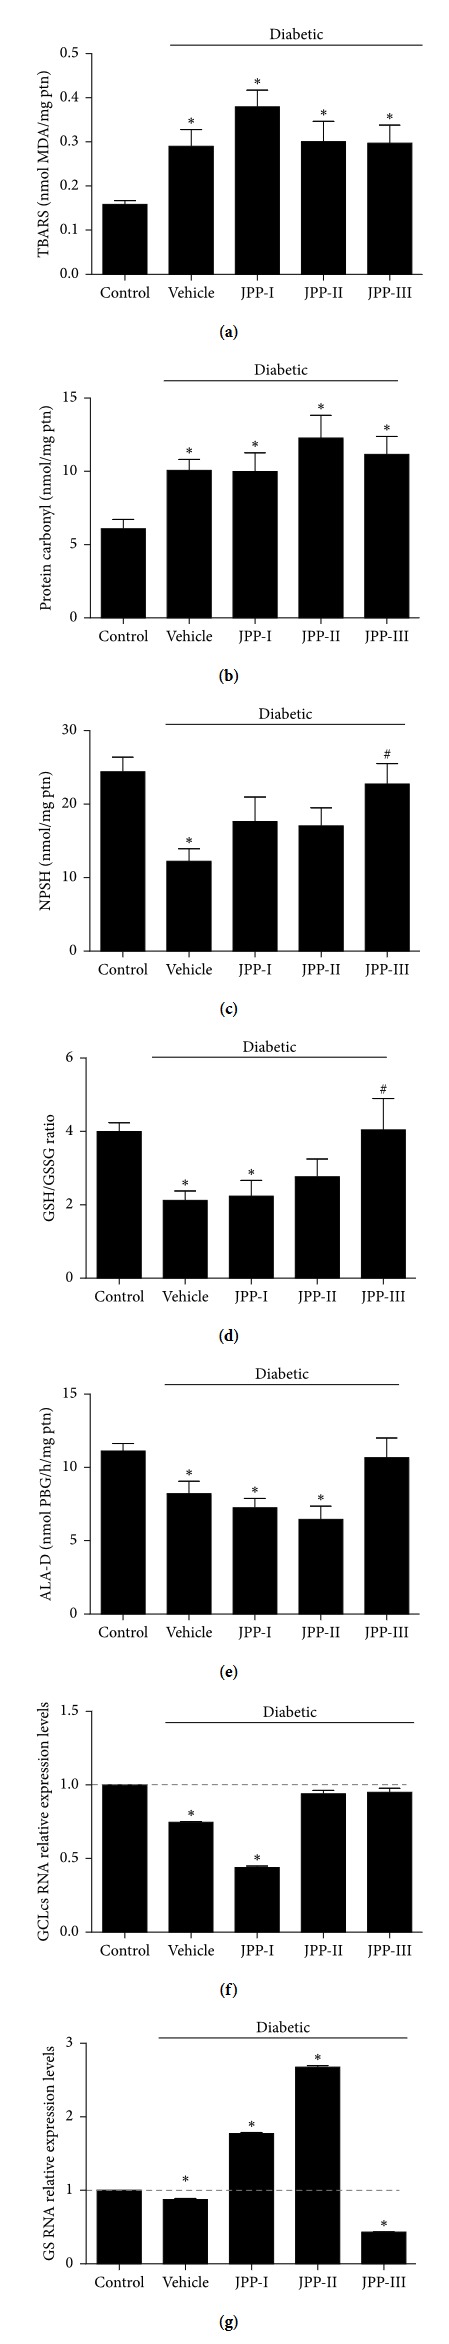
TBARS (a), protein carbonyl (b) and NPSH (c) levels, GSH/GSSG ratio (d), δ-ALA-D activity (e), and gene expression of GCLcs (f) and GS (g) in the liver of diabetic rats fed high-fat diet and treated with jaboticaba peel powder or vehicle for 8 weeks (means ± SEM, n=8). ∗Different from the control group (p < 0.05). #Different from the diabetic-vehicle group (TBARS, protein carbonyl, NPSH, GSH/GSSG ratio, and δ-ALA-D: ANOVA-Duncan's test; GCLcs and GS: ANOVA-Dunnett's test; p < 0.05). The gene expression data were normalized by β-actin gene expression, and mean ± SD were obtained from three independent repetitions. TBARS = thiobarbituric acid reactive substances; NPSH = nonprotein thiol group; GSH = reduced glutathione; GSSG = oxidised glutathione; δ-ALA-D = δ-aminolaevulinic acid dehydratase; GCLcs = glutamate-cysteine ligase, catalytic subunit; GS = glutathione synthase.